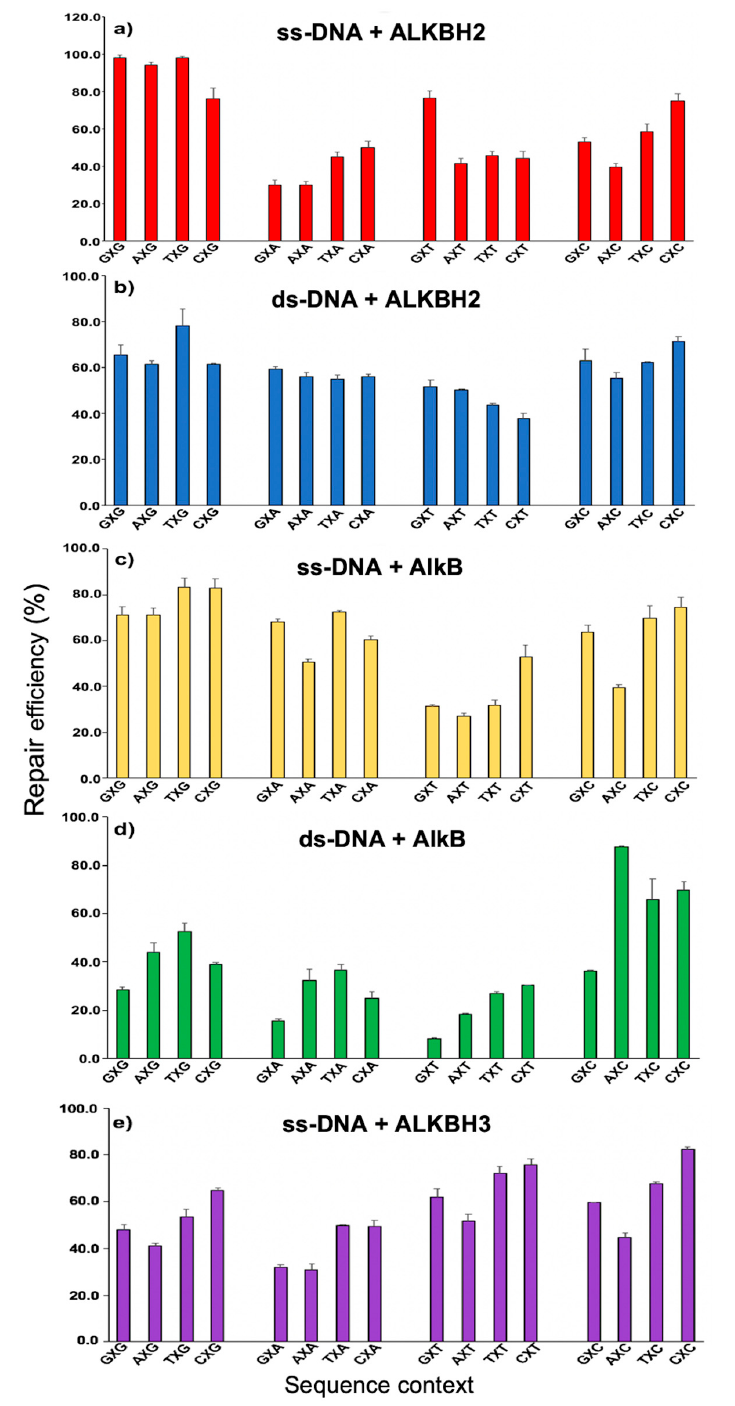
Figure 2. ε A repair efficiencies under 16 different sequence contexts (3 ′ base fixed). The oligonucleotide concentration was fixed at 2.5 µ M. Distinct conditions are shown as follows: ( a ) ss-DNA + 2.2 µ M ALKBH2 (red); ( b ) ds-DNA + 1.1 µ M ALKBH2 (blue); ( c ) ss-DNA + 0.4 µ M AlkB (yellow); ( d ) ds-DNA + 1.1 µ M AlkB (green); and ( e ) ss-DNA + 4.0 µ M ALKBH3 (purple). Percentages of repair for all reactions are summarized in Table S1. Error bars represent the standard deviation from triplicate experiments.